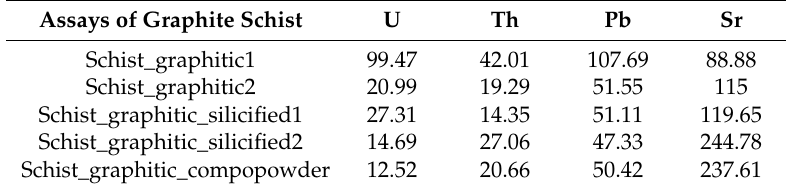
Table 6. Assays related to graphitic schists—Inovska Reka occurrence (values are in ppm). Assays of Graphite